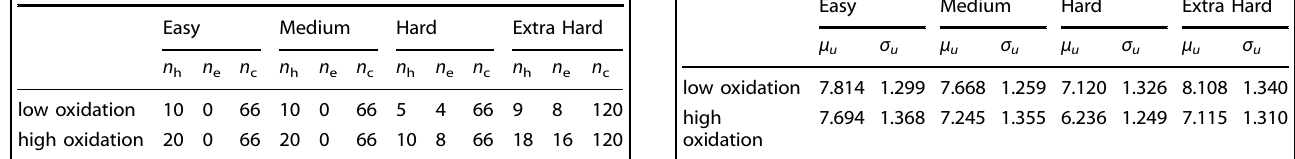
Table 3. Summary of the number of hydroxyl groups n h , the number of epoxide groups n e , and the number of carbon atoms that are hosts for functional groups n c for all experiments.